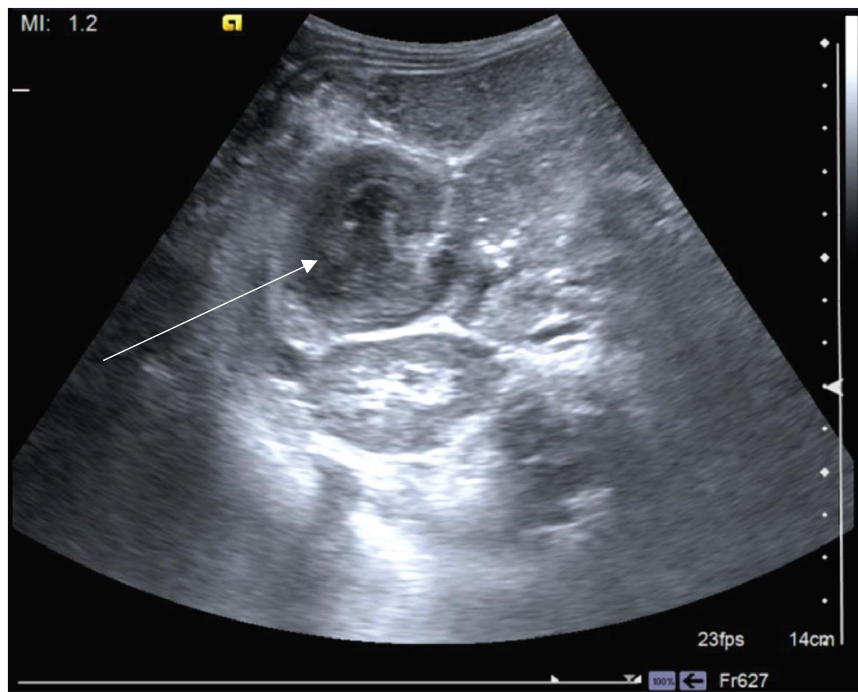
Figure 2: Abdominal ultrasound. Ultrasound showing target sign (arrow), which is suggestive of